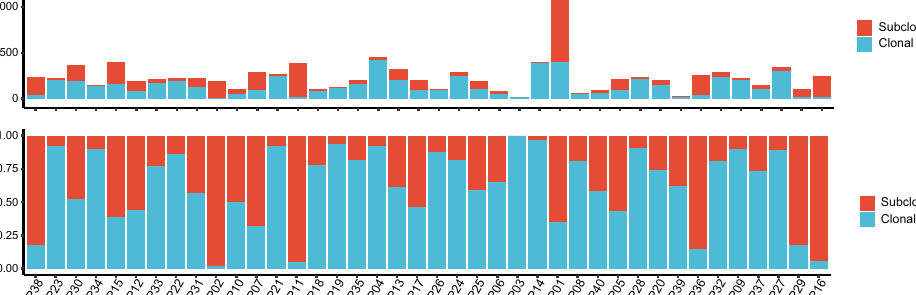
(Fig. 2b, c). Using CNV ITH, a median of 0.485 (range 0.02 – 0.99 per sector) was found in SCLC (Fig. 2d). Among them, IL7R , PIK3CA , SETDB1 , TERT , SEPT9 , MYC , CEBPA , and CD274 genes were ampli fi ed as frequently recurring clonal genes, while the clonal depleted genes like CBWD3 , RB1 , and PTEN were identi fi ed in our patients (Supplementary Fig. 2e).